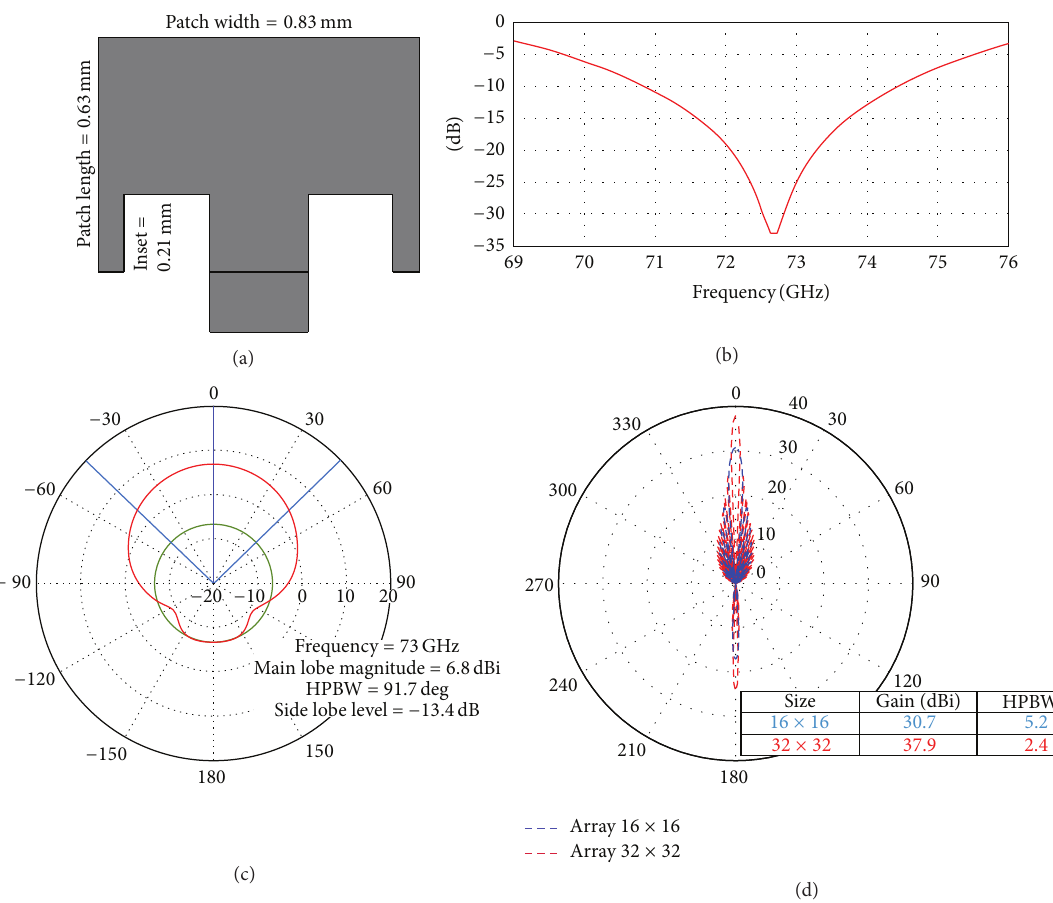
Figure 5: (a) Designed patch antenna, (b) reflection coefficient, (c) single element E-field, (d) 16 × 16 and 32 × 32 array E-field.